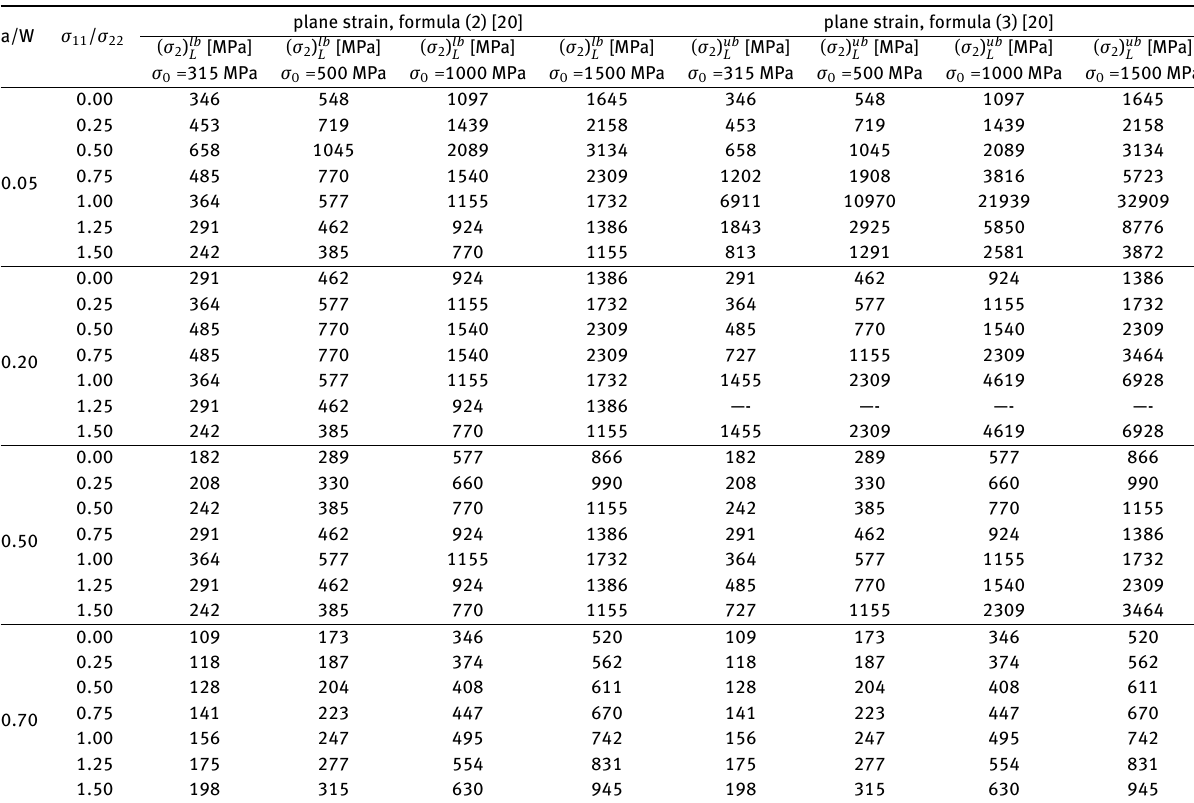
Table 6: Values of the limit loads ( σ 2 ) lb mulae (2) and (3)